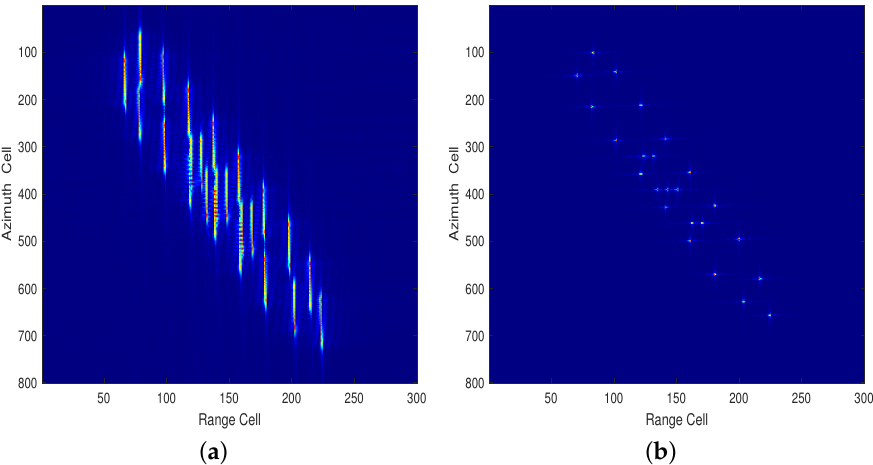
Figure 6. The performance of the motion compensation method on simulated data. ( a ) SAR subimage. ( b ) RD imaging after motion compensation.